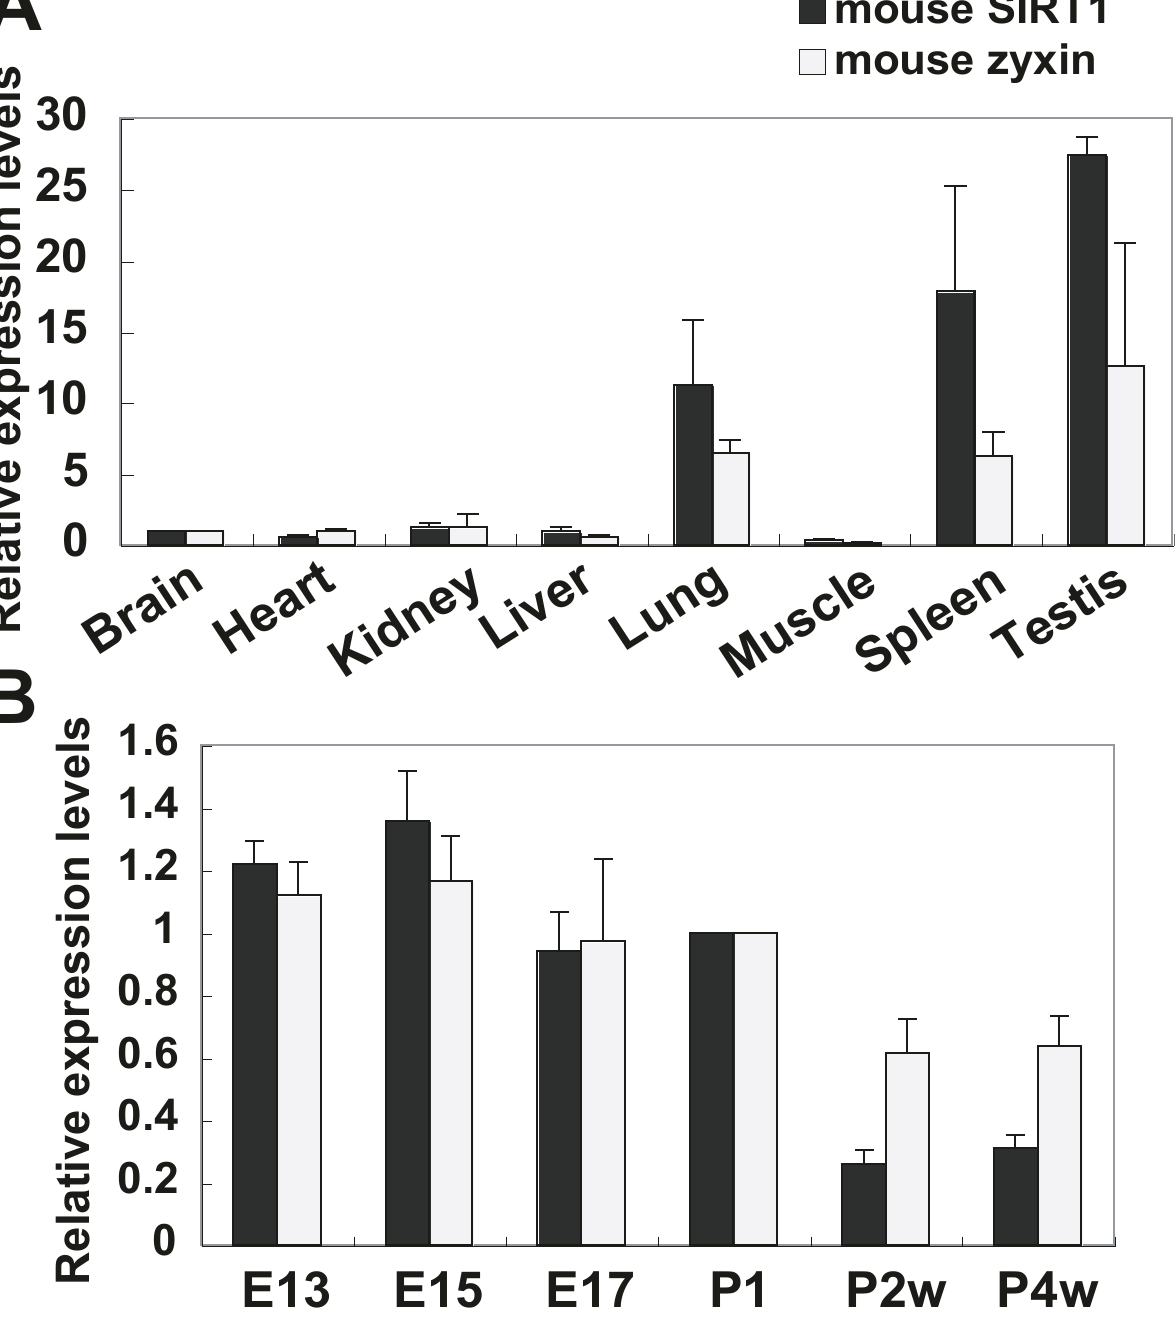
Figure 5 Relative expression levels of SIRT1 and zyxin mRNA in various mouse tissues and developmental stages . (A) Quantitative real-time PCR expression profiles of mouse cDNA from different tissues. The expression levels of SIRT1 and zyxin relative to those of GAPDH were assessed by ΔΔ Ct method. Results are the mean ± S.E from three independent reac- tions. (B) Real-time PCR expression profiles of mouse cDNA from whole brain at different developmental stages. The expres- sion levels of SIRT1 and zyxin mRNA are represented as relative fold as compared with the value in brain(A) and P1(B). E13, 15, 17; Embryonic day 13, 15, 17. P1, P2w, P4w: Post natal day 1, 2 weeks, 4